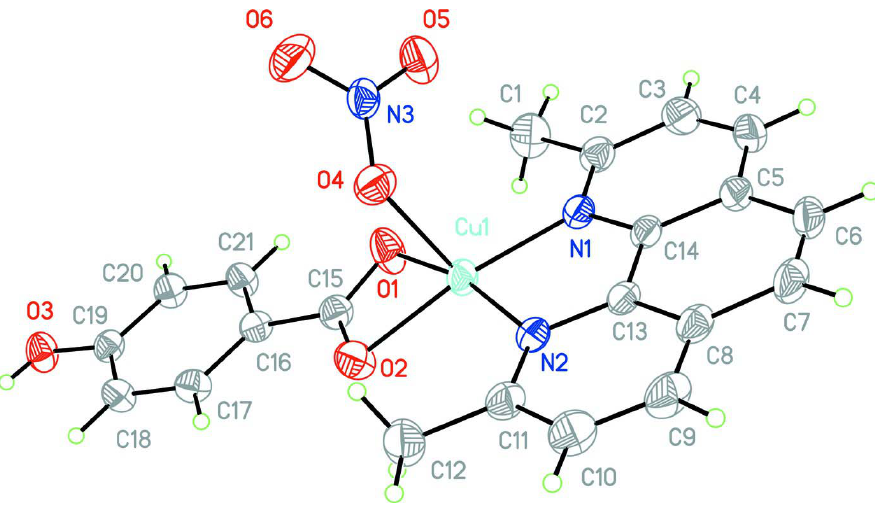
Figure 1 The molecular structure of the title complex, with atom labels and 30% probability displacement ellipsoids.